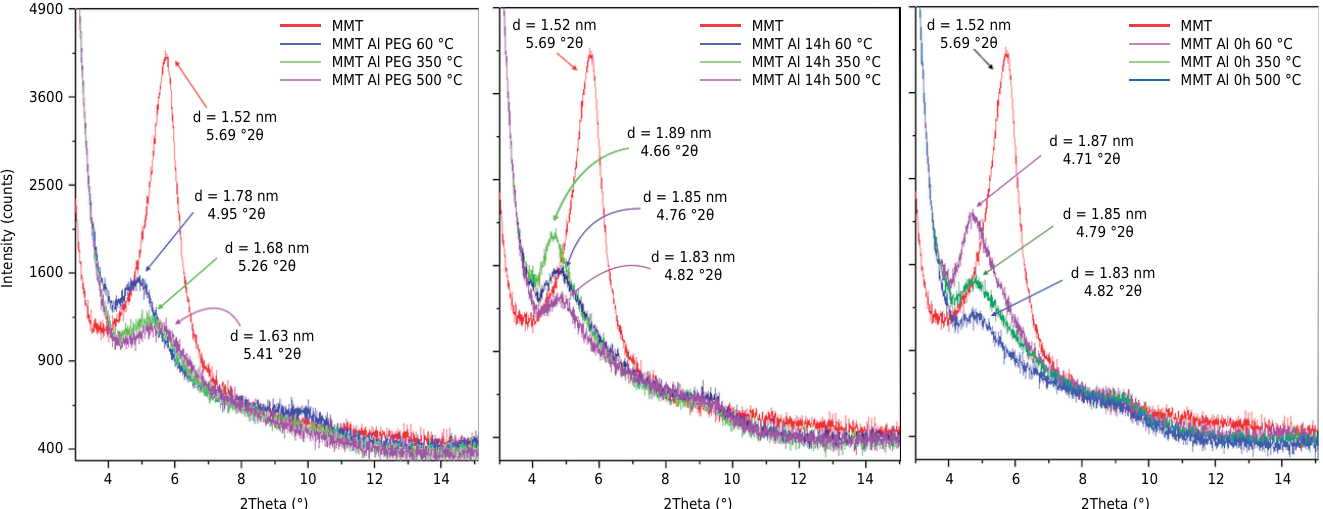
Figure 6. XRD samples of AlPEG (a), Al14h (b), and Al0h (c) heated to 60, 350, and 500 °C compared to natural MMT.